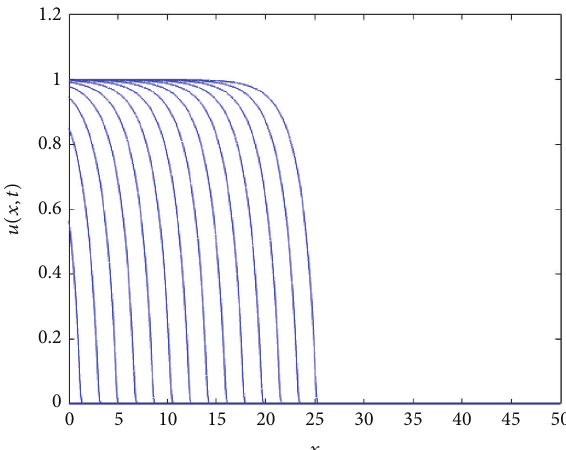
Figure 2: Evolution of a compact support function as initial condi- tion under the reaction-diffusion convection process described by (6). The numerics show that as the time grows, the approximative solution tends to the sharp traveling wave solution. Note the agreement between the calculated speed of the sharp solution with that for which we have the saddle-saddle heteroclinic trajectory; see Figure 3. The profiles are plotted at equal time intervals 𝑡 = 1,2, 3, .. . with 𝑔(𝑢) = 𝑢(1−𝑢) and 𝐷(𝑢) = 𝑢(1.0+𝛽𝑢) for 𝛽 = 𝑘 = 1 , compact support initial conditions (in a larger domain −50 < 𝑥 < 40 , 𝑢(𝑥,0) = 1 for 𝑥 < −20 , and 𝑢(𝑥,0) = 0 for 𝑥 ≥ 20 ).